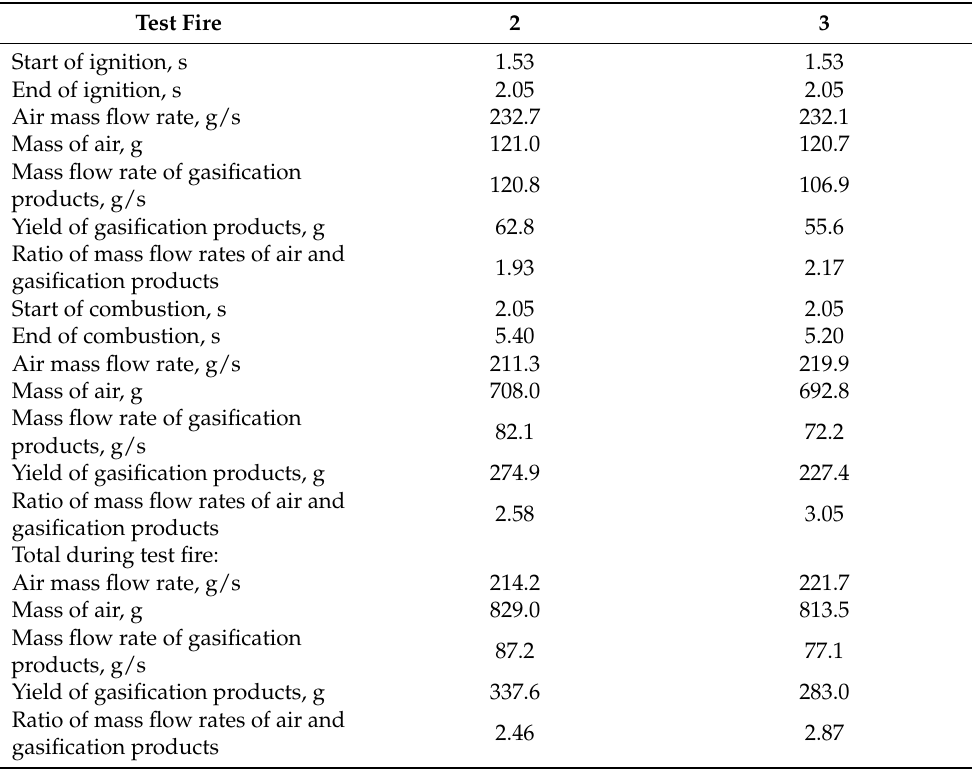
Table 1. Operation parameters of GG at hydrogen-assisted